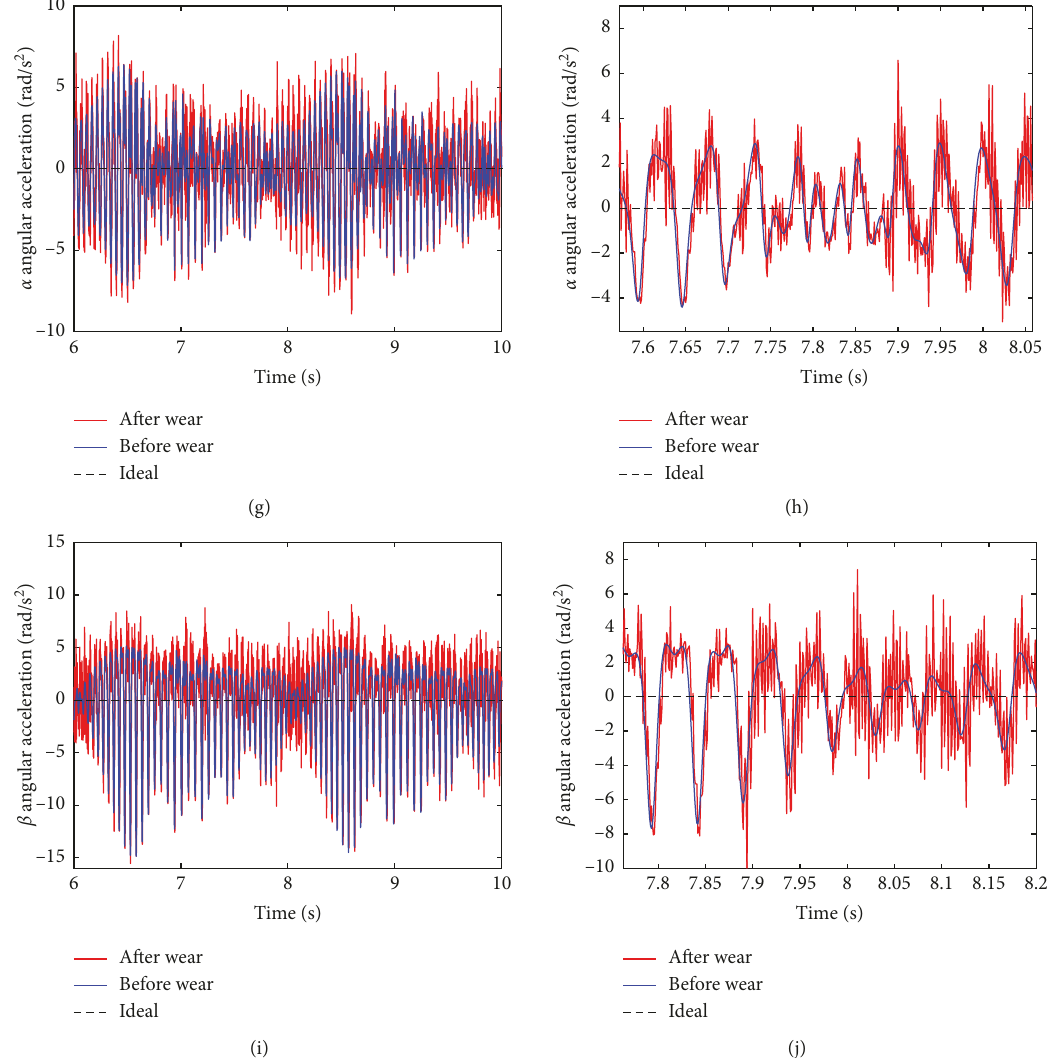
Figure 12: Comparison of acceleration curves before and after wear. (a) Acceleration curve in X direction, (b) enlarged view of acceleration curve in X direction, (c) acceleration curve in Y direction, (d) enlarged view of acceleration curve in Y direction, (e) acceleration curve in Z direction, (f) enlarged view of acceleration curve in Z direction, (g) angular acceleration curve in α direction, (h) enlarged view of angular acceleration curve in α direction, (i) angular acceleration curve in β direction, and (j) enlarged view of angular acceleration curve in β